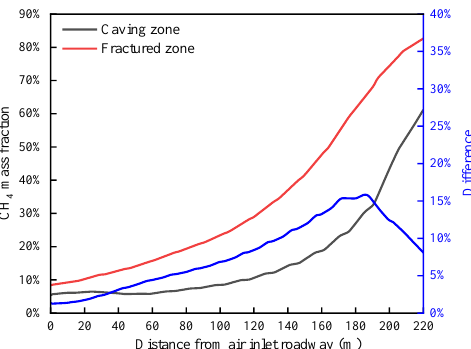
Figure 7. Comparison diagram of gas mass fraction variation curve in caving zone and fracture zone.